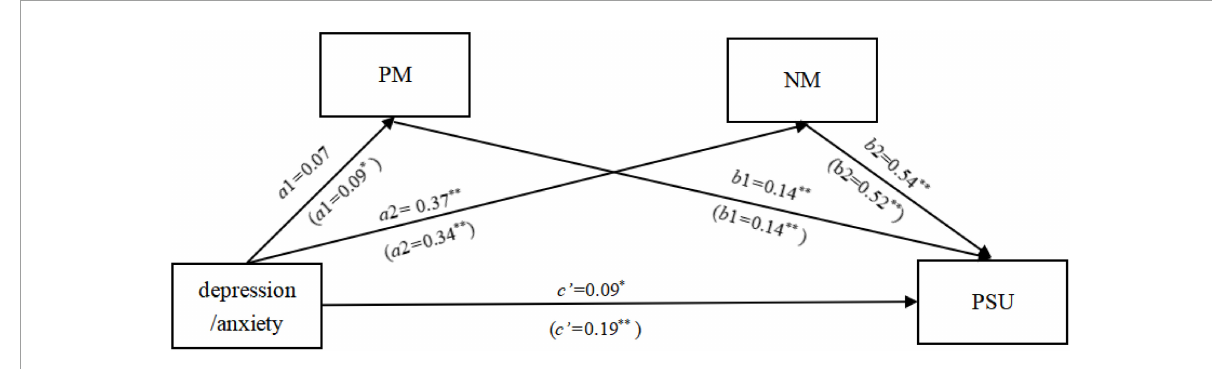
FIGURE1 Results of the mediated model among the key study variables. The values in parentheses are the values calculated when anxiety is the independent variable; PM, positive metacognition about smartphone use; NM, negative metacognition about smartphone use; PSU, problematic smartphone use; * p < 0.05, ** p < 0.01.